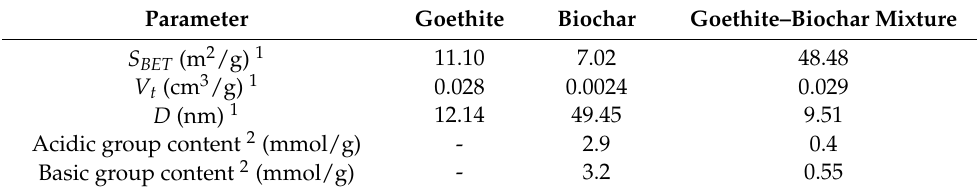
Table 1. Specific surface area, porosity parameters and acidic/basic group content for adsorbents.